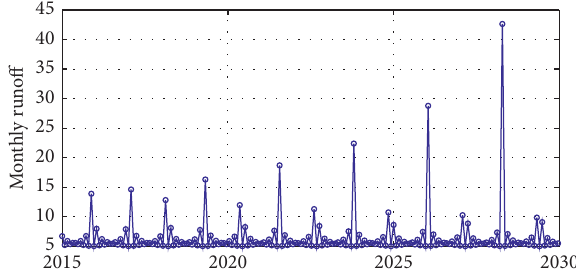
Figure 12: Simulation results of monthly runoff in Jianchang field (2005 ∼ 2015).